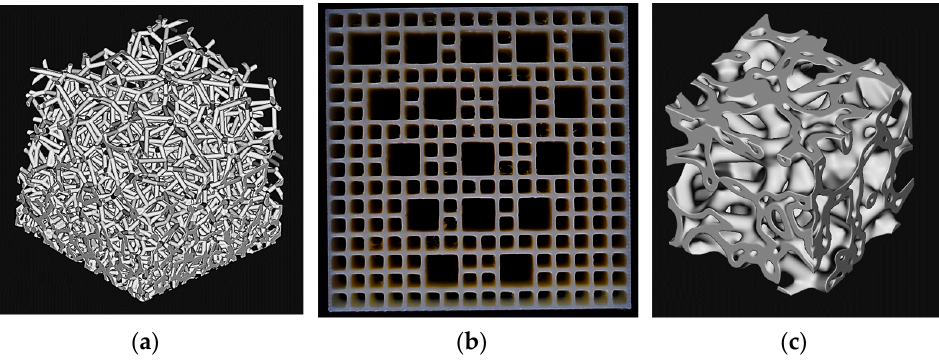
Figure 17. Three examples of combining different methods in the classification: ( a ) gradation of unit cell size applied to a Voronoi lattice; ( b ) gradation of beam deletion, from [33]; ( c ) hybridization of beam- and surface-based elements in a perturbed cellular material.